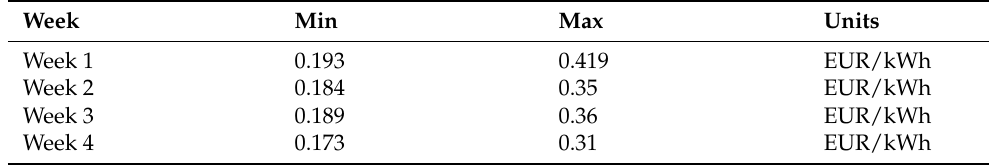
Figure 8. Electricity price variation per hour for each week of May 2022. ( a ) Week 1: 2nd–6th of May, ( b ) Week 2: 8th–13th of May, ( c ) Week 3: 15th–20th of May, ( d ) Week 4: 22nd–27th of May. Table 6. Electricity price minimum and maximum